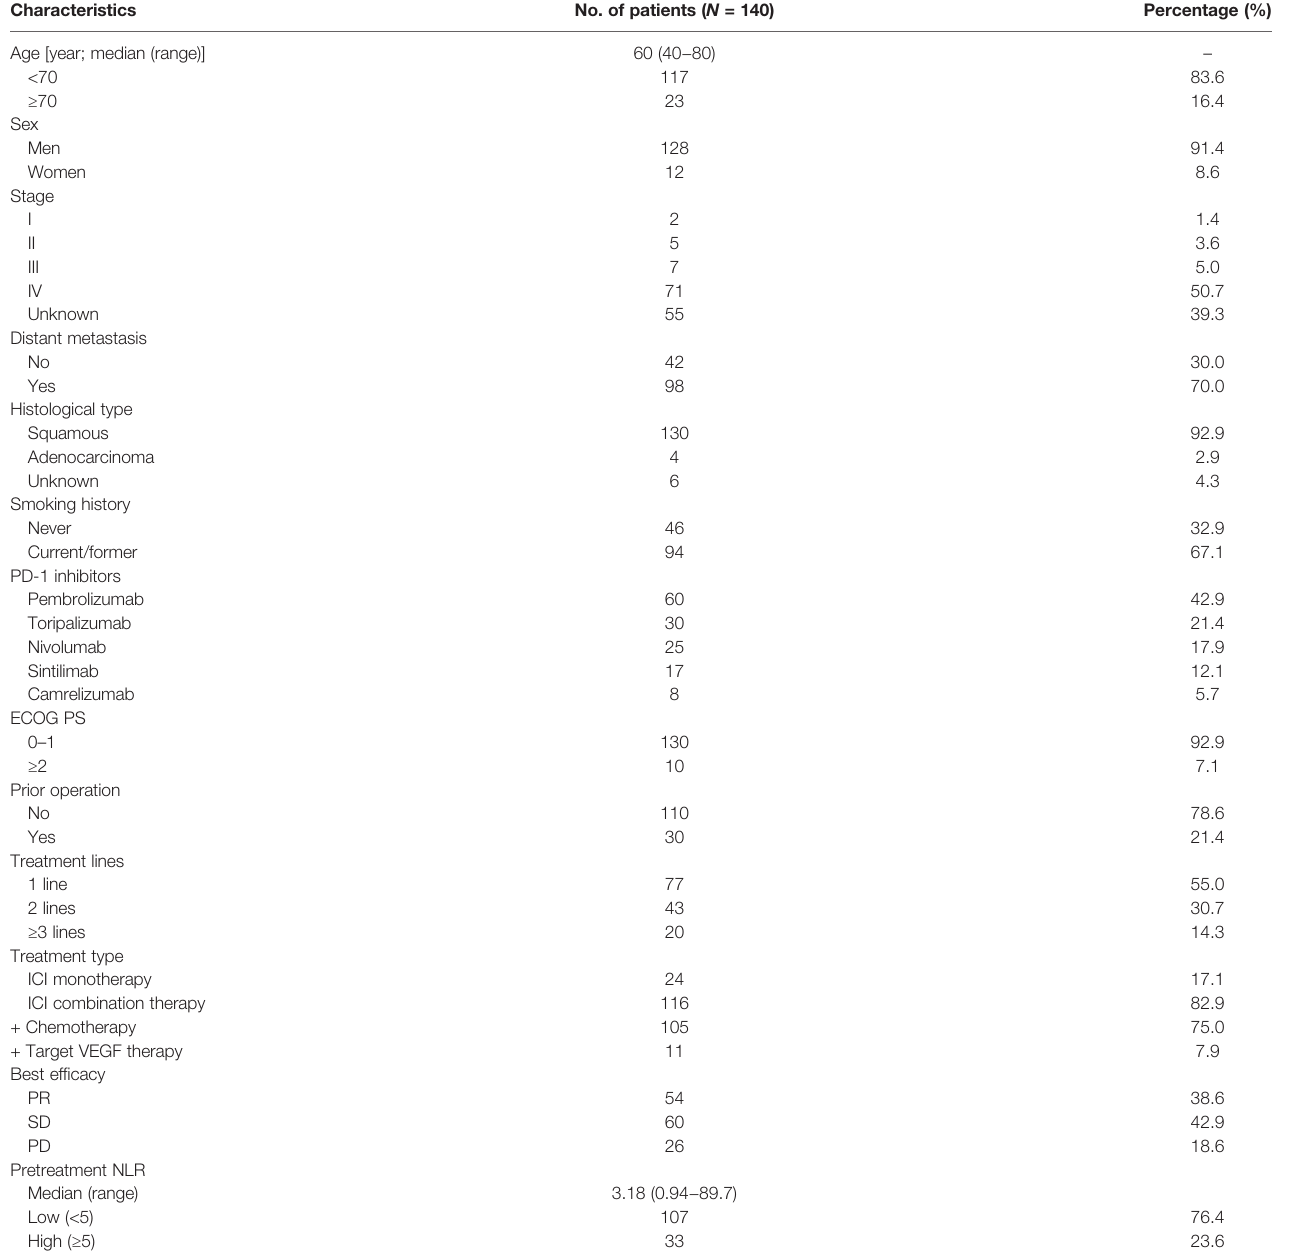
TABLE 1 | Characteristics of included